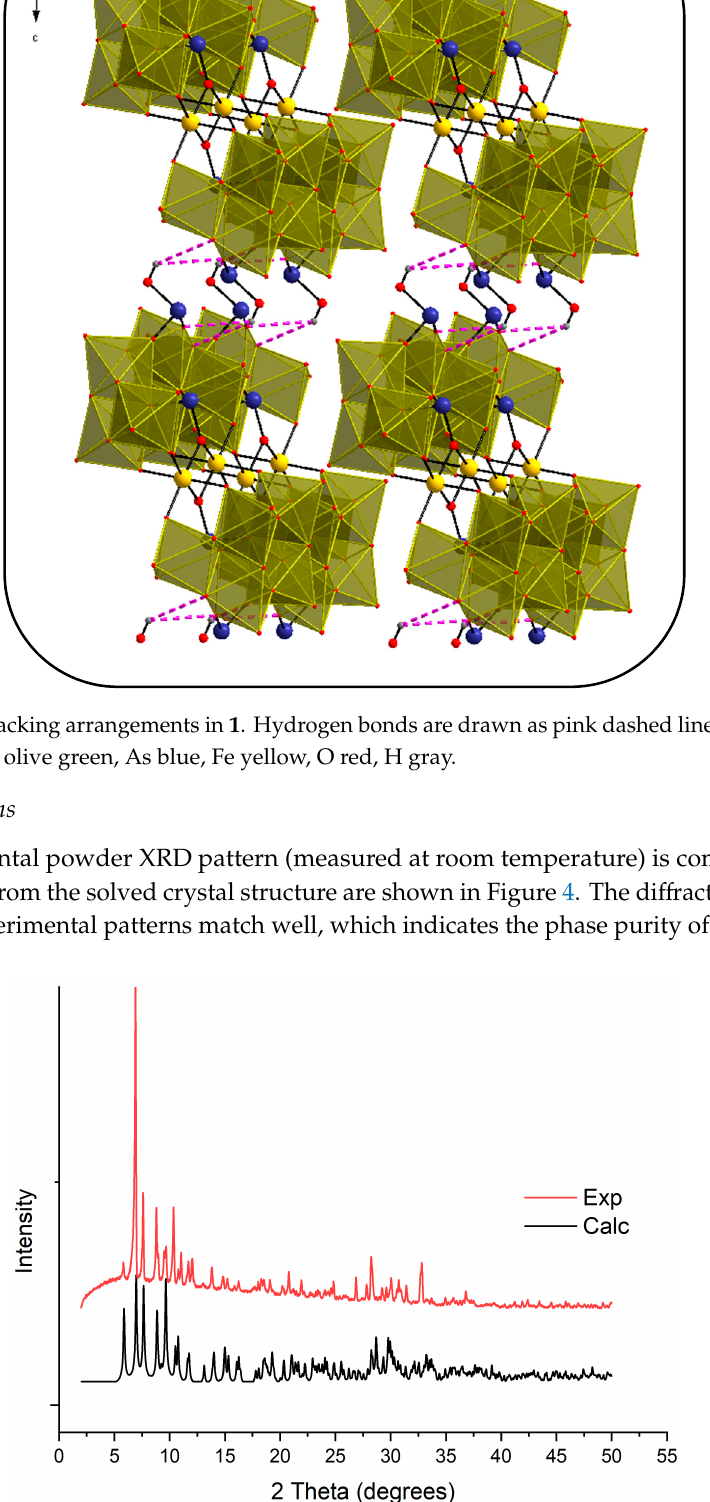
Figure 4. Experimental (red) and simulated (black) X-ray diffraction pattern of Na-1.